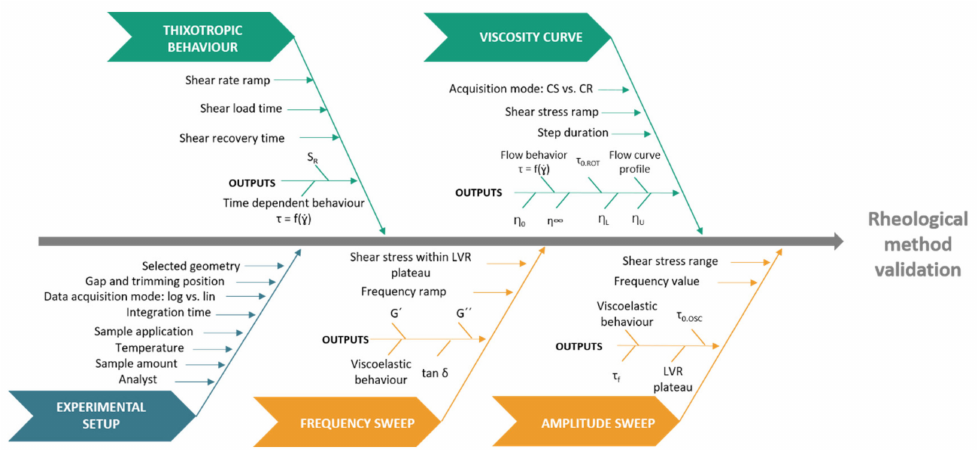
Figure 1. Hypothetical Ishikawa diagram applied to the acquisition and validation of a rheology